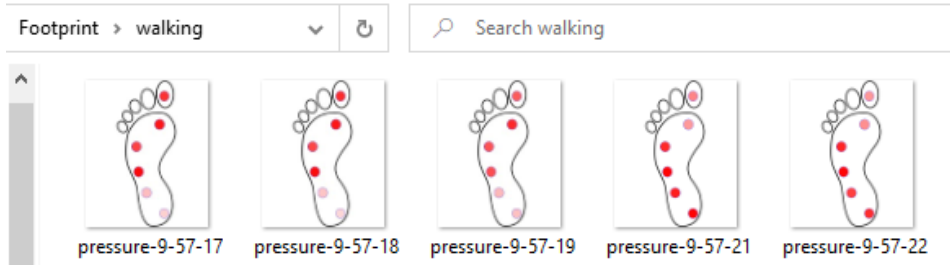
Figure 18. The COP progression line during a stance phase with light red indicating applied pressure, following the successive activation of FSR 5 —heel area, FSR 4 to FSR 1 —midfoot, and FSR 0 —hallux. Further on, the FSR readings are plotted in Figure 19 alongside the EMG of the tibialis anterior and gastrocnemius respectively. As illustrated, plantar pressures and